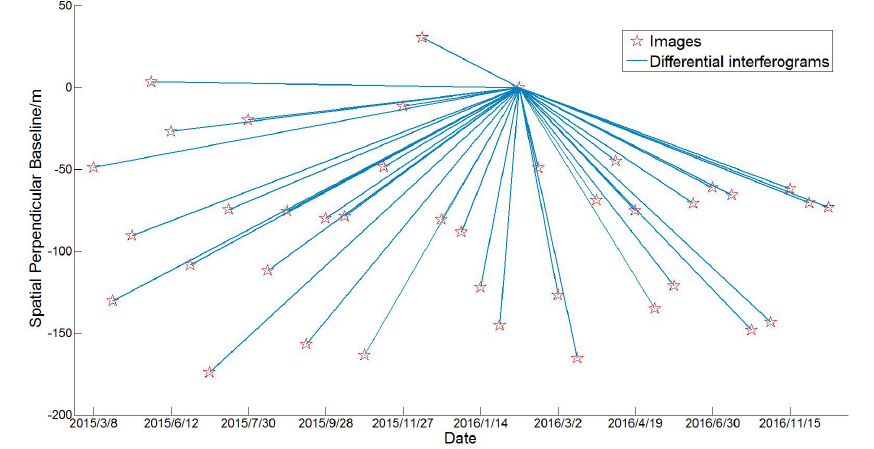
Figure2. The spatial perpendicular and temporal baselines of each differential